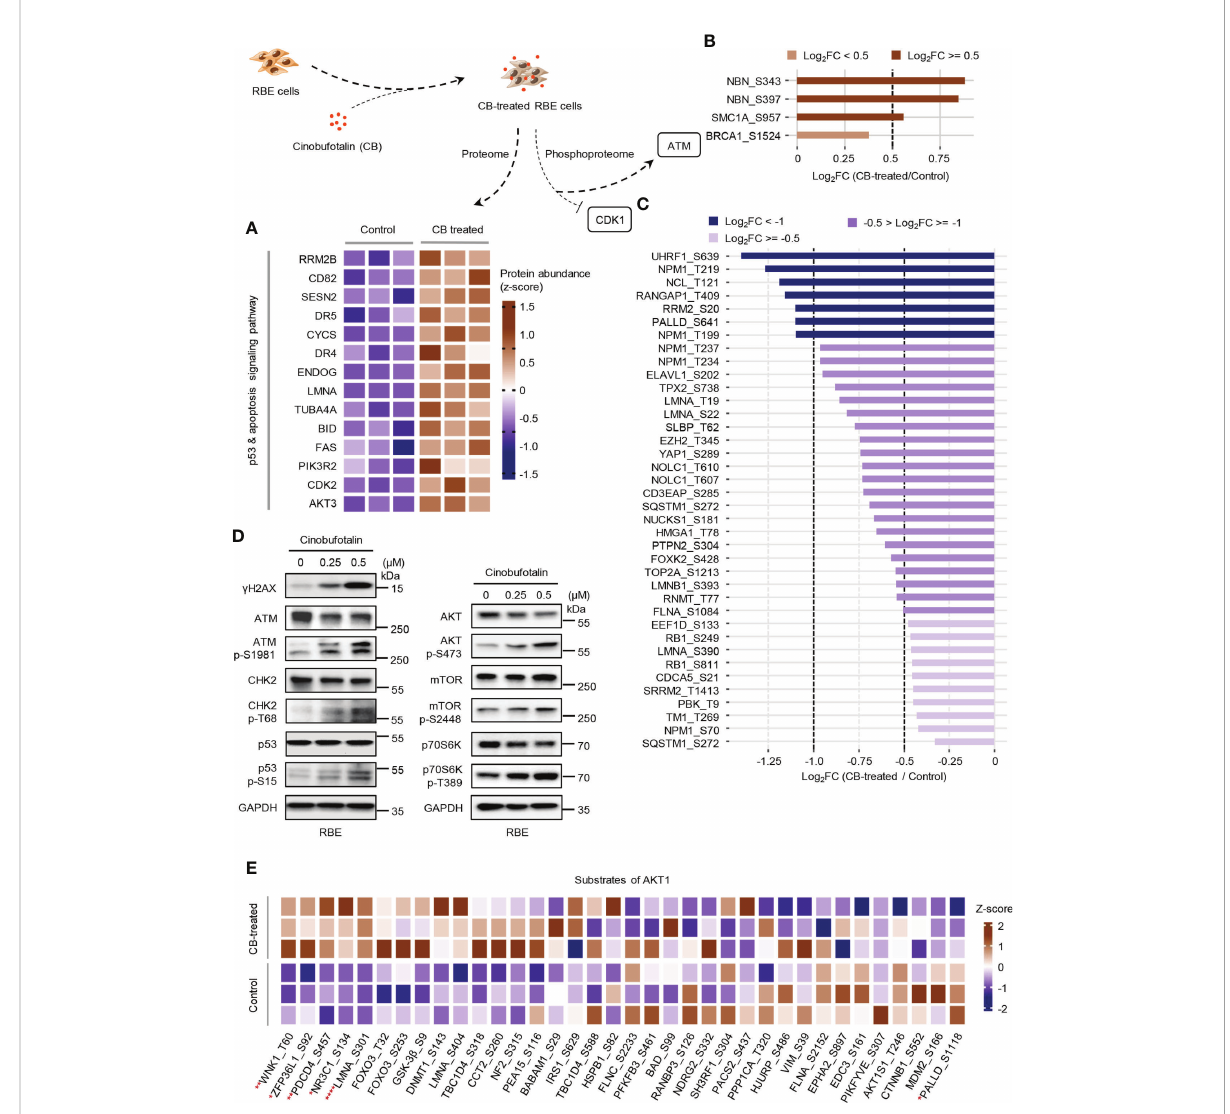
FIGURE 5 CB treatment remodels proteome and phosphoproteome of RBE cells. (A) Heatmap of signi fi cantly changed proteins of the p53 and apoptosis signaling pathway in CB-treated RBE cells. Brown represents up-regulated, blue means down-regulated. (B, C) The statistics of the phosphosites regulated by ATM (B) and CDK1 (C) . (D) Veri fi cation of the expression of DNA damage, p53 signaling and AKT signaling pathway-related proteins and phosphosites by immunoblotting. (E) The heatmap shows the MS detected phosphosites regulated by AKT1. * p < 0.05, ** p < 0.01, **** p < 0.0001, Student ’ s t